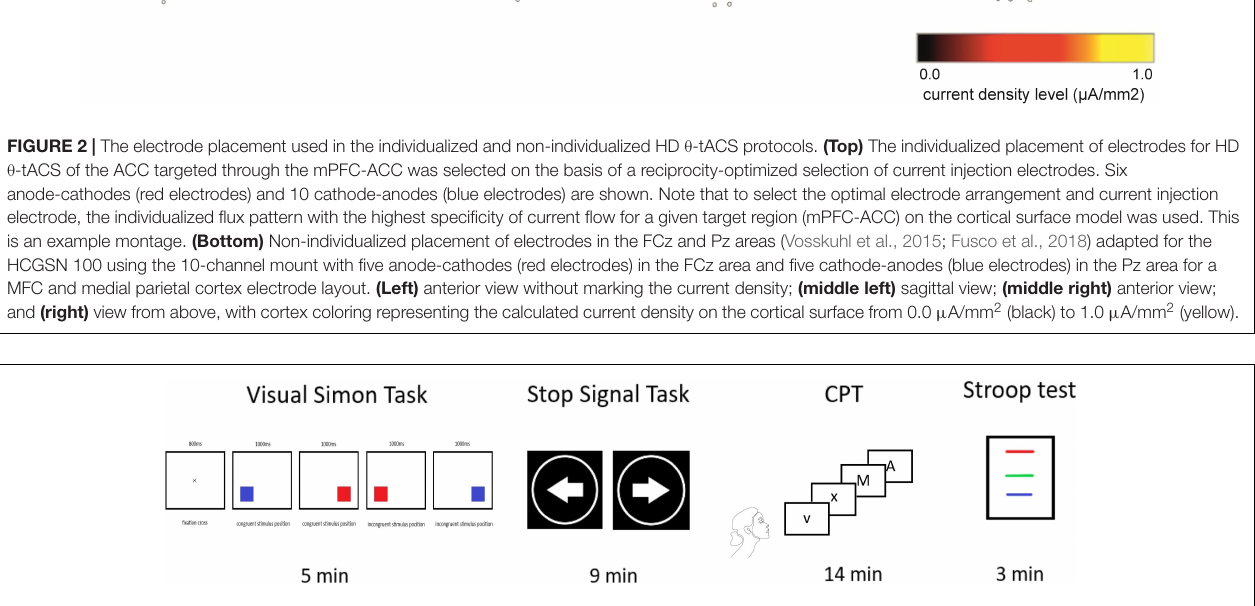
FIGURE 3 | Flow chart of the psychometric measurement. Flow chart of the psychometric measurement. Illustration of the individual assessments performed for the following periods: Visual Simon Task = 5 min, Stop Signal Task = 9 min, Conners’ Continuous Performance Test 3rd edition (CPT III) = 14 min, Stroop test = 3